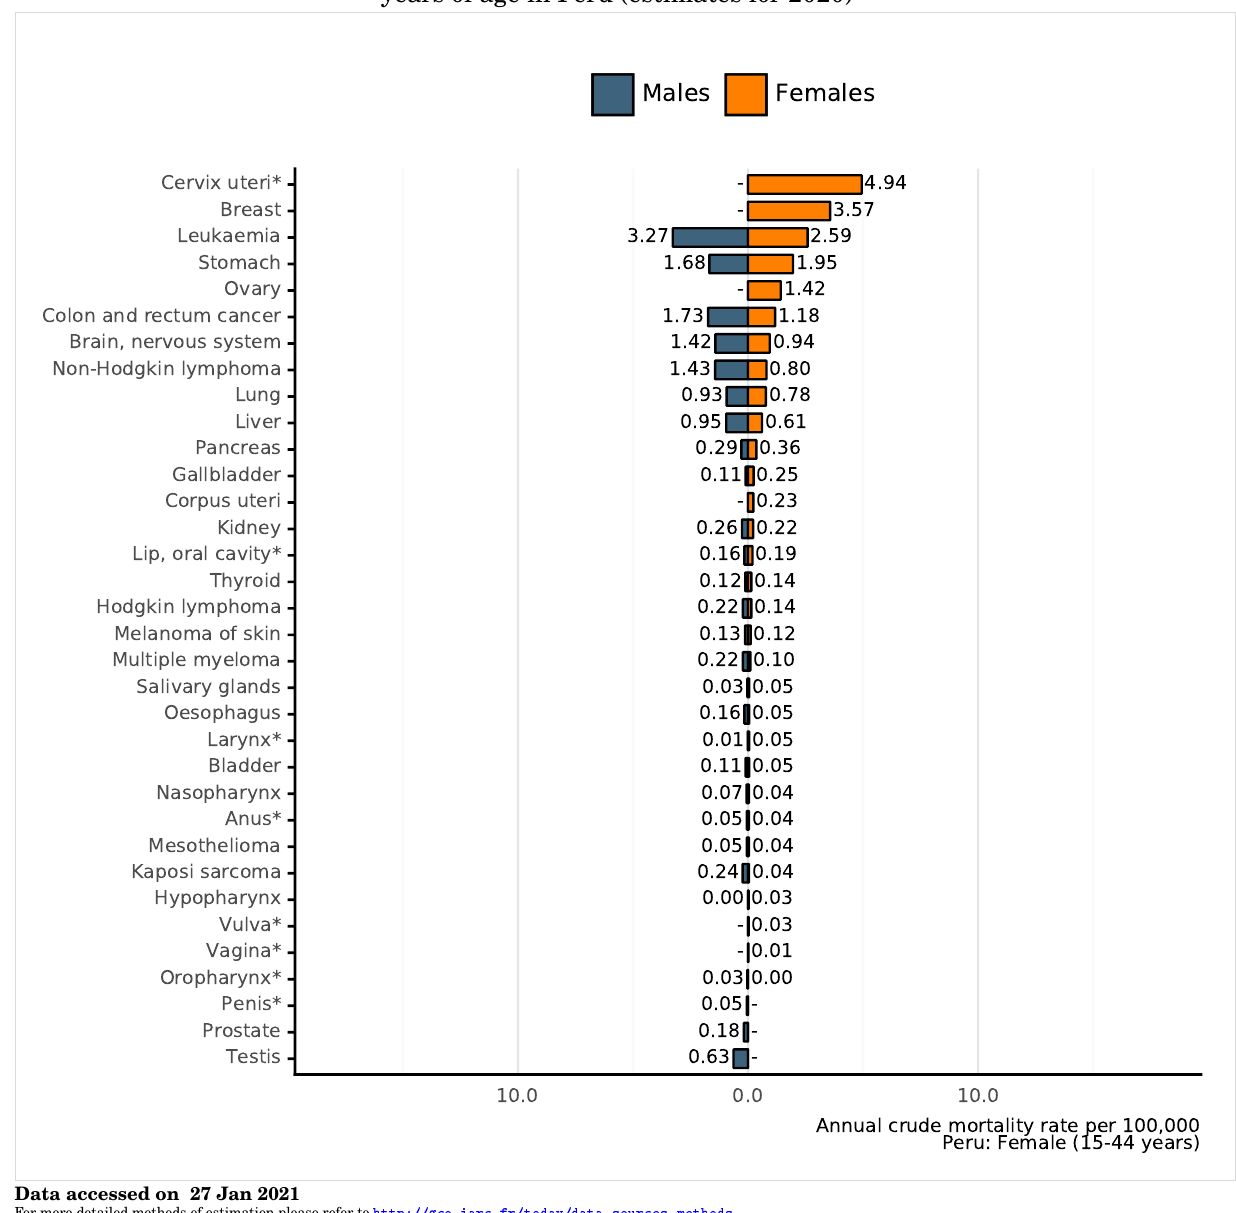
Figure 7: Comparison of HPV related cancers mortality to other cancers among men and women 15-44 years of age in Peru (estimates for